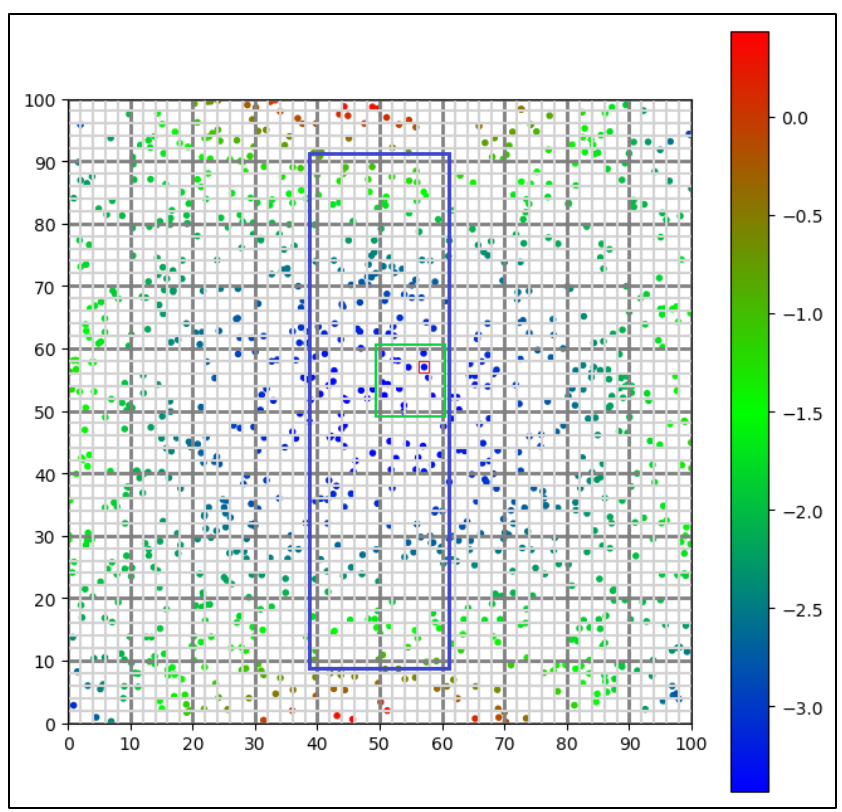
Figure 14. Schematic diagram of distress detection. Different colors represent different distances to the local reference plane.